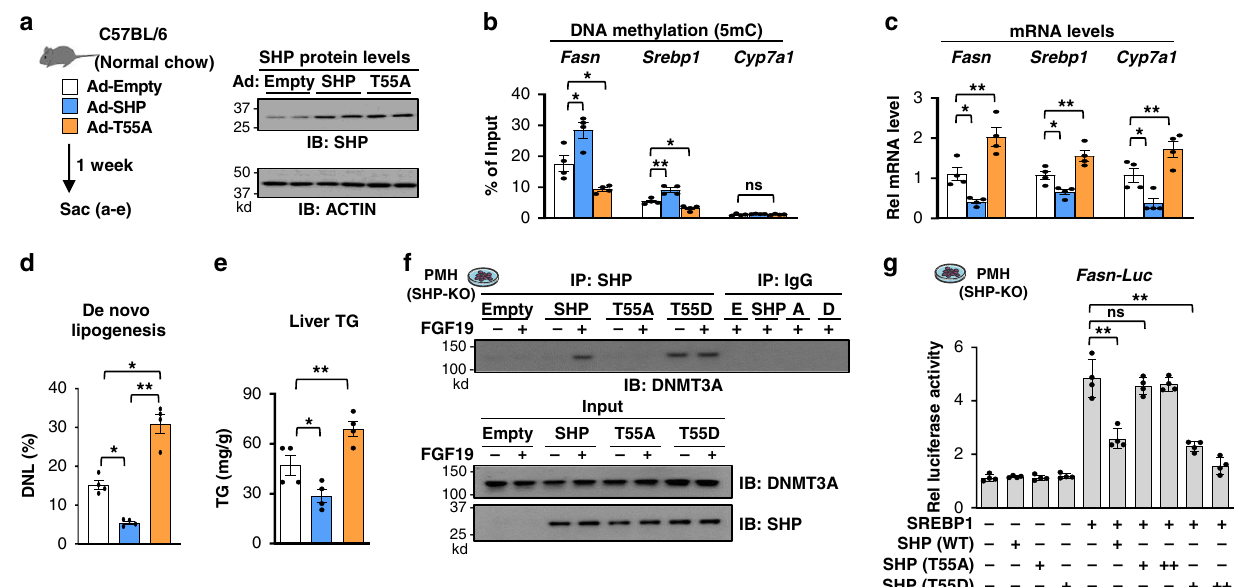
Fig. 6 FGF15/19-induced phosphorylation of SHP is required for its interaction with DNMT3A in repression of hepatic lipogenesis. a – e C57BL/6 mice were infected by adenoviruses that express SHP-WT or T55A or by empty adenoviruses, and one week later the mice were sacri fi ced. a Experimental outline (left). Levels of SHP protein determined by IB (right). b DNA methylation at the promoters of the indicated genes measured by MeDIP. c Levels of mRNA of the indicated genes measured by RT-qPCR. d For 2 days prior to brief fasting and sacri fi ce, drinking water for the mice was 4% deuterated water. Hepatic DNL was measured as described in Methods. e Liver triglyceride (TG) levels. f – g PMHs were prepared from SHP-KO mice and cultured for 48 h. The PMHs were transfected with plasmids expressing control, SHP-WT, a phosphorylation-defective SHP-T55A mutant, or a phosphorylation-mimic SHP- T55D mutant. Seventy two hours later, cells were cultured in serum-free media overnight and then treated with vehicle or FGF19 for 2 h ( f ) or 6 h ( g ). f Interaction of SHP and DNMT3A determined by CoIP assays. Four culture plates were pooled for each sample. The experiment was repeated two times with similar results. g Luciferase activities normalized to β -galactosidase activities in PMH transfected with the indicated plasmids. b – e , g The mean values ± SD are plotted ( b – e , n = 4 mice; g , n = 4 PMH culture dishes). Statistical signi fi cance was determined by one-way ANOVA with the Tukey post-test. * P